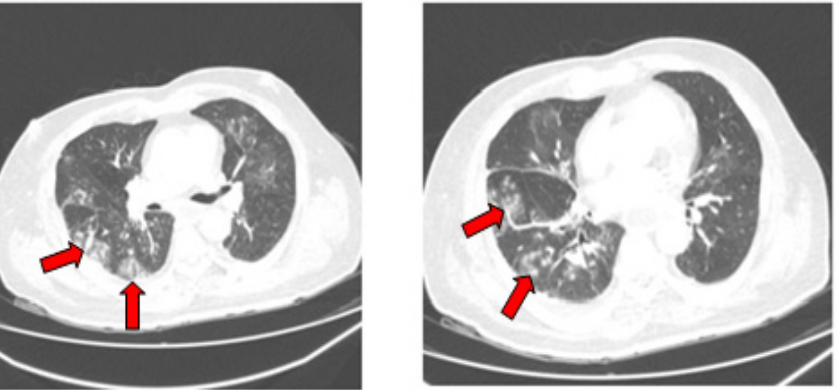
Figure 1. Chest CT scan revealed multiple vessel-related nodular opacities with grand glass halo with central and peripheral distribution, made at the time of COVID-19 diagnosis.